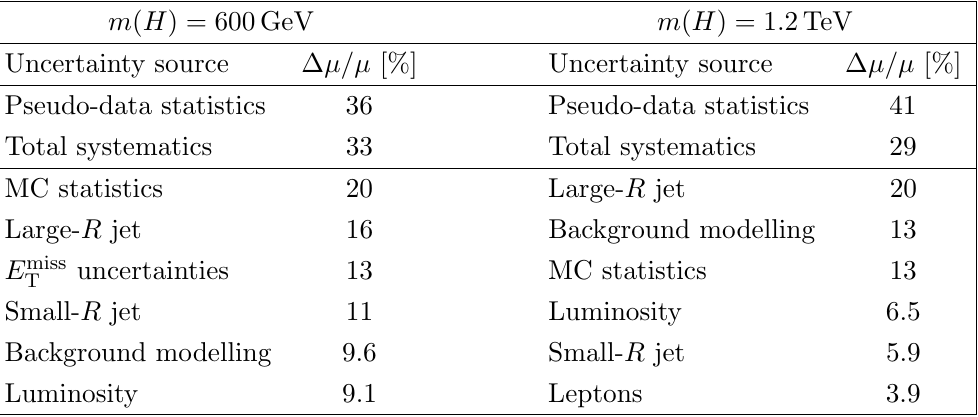
Table 5 . The relative uncertainties from the leading uncertainty sources in the best-(cid:12)t signal- strength parameter (cid:22) of hypothesised signal production of ggF H ZZ with m ( H ) = 600 GeV ! and m ( H ) = 1 : 2 TeV. For this study, the H ZZ production cross section is assumed to be 95 fb ! at 600 GeV and 13 fb at 1.2 TeV, corresponding to approximately the expected median upper limits at these two mass